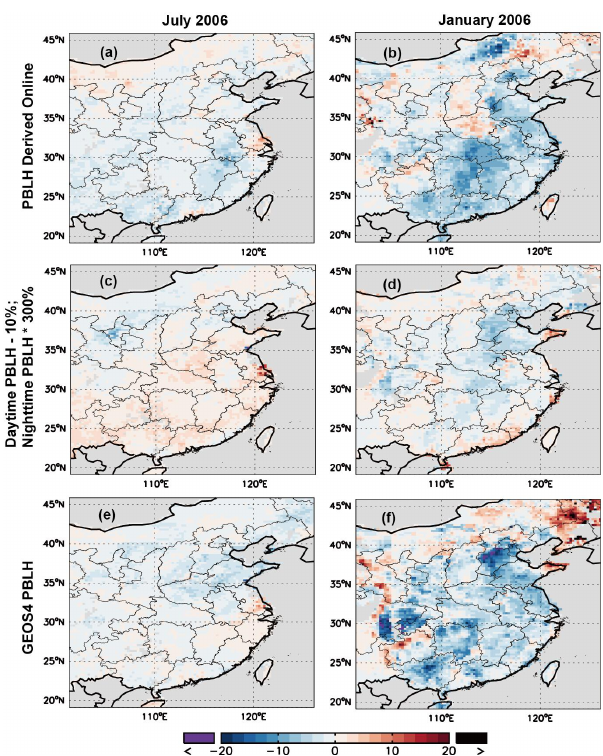
Fig. 6. Spatial distribution of percentage differences between mod- eled NO 2 columns with and without adjustments in PBLH. (a, b) The PBLH is calculated online by GEOS-Chem instead of be- ing taken directly from GEOS-5. (c, d) The PBLH is decreased by 10% in the daytime and tripled at night. (e, f) The PBLH is adjusted based on values from the GEOS-4 meteorological